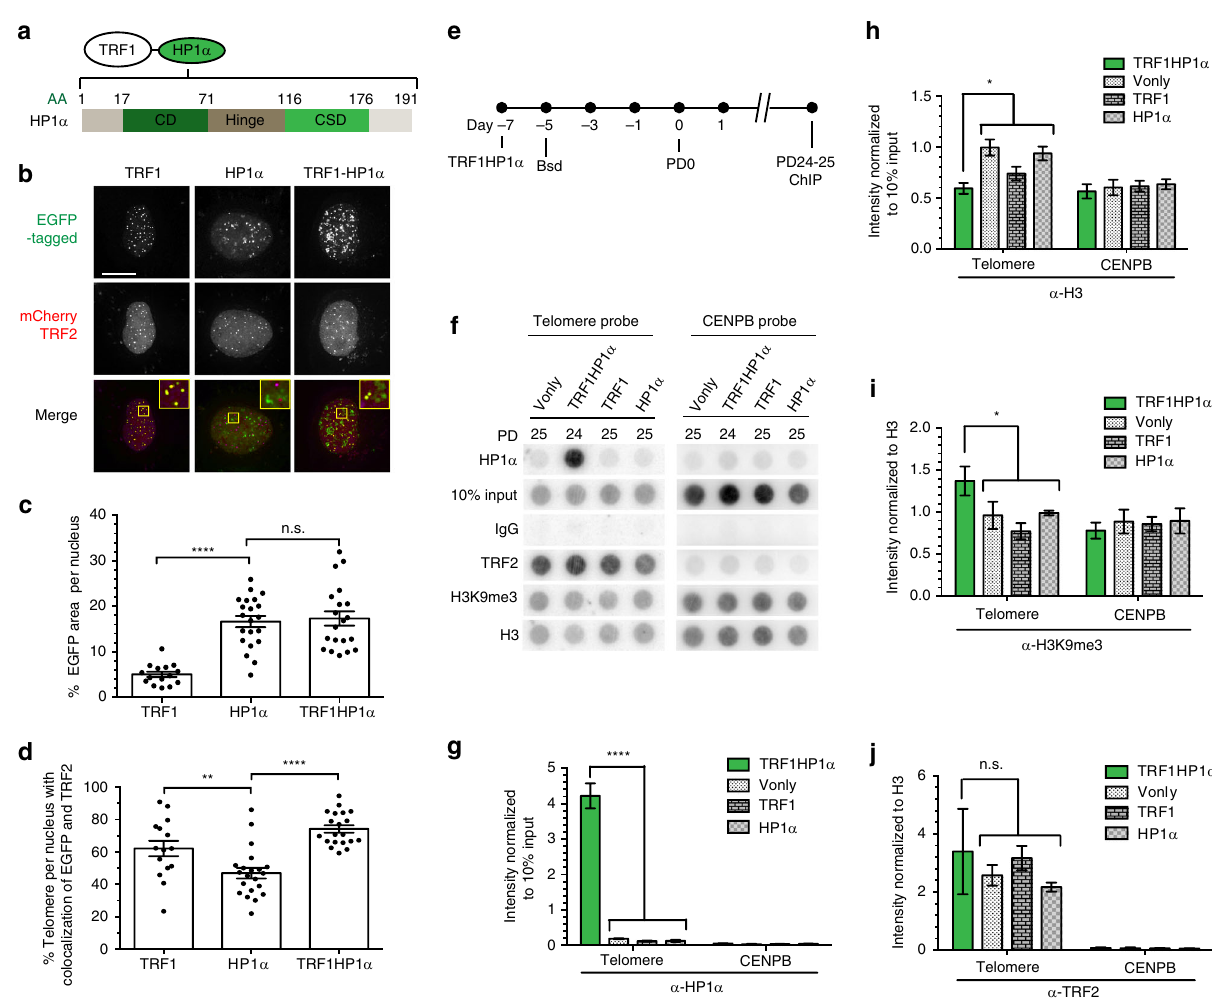
Fig. 1 Tethered HP1 α at telomeres locally increases H3K9me3. a Schematic of HP1 α fused to TRF1. HP1 α consists of a chromo domain (CD), a hinge, and a chromo shadow domain (CSD); AA (amino acid). b − d Fluorescence imaging of UM-UC3 cells cotransfected with mCherry-tagged TRF2 and EGFP-TRF1, EGFP-HP1 α , or EGFP-TRF1HP1 α -fusion 48 h after transfection ( n = 15 – 21 nuclei). b Representative images. mCherry shown as magenta in merged image. Scale bar: 10 µ m. c Quanti fi cation of % EGFP area per nucleus **** p < 0.0001; n.s. (no signi fi cance). d Quanti fi cation of % telomere per nucleus with colocalization of EGFP and TRF2 (mCherry) ** p = 0.0065; **** p < 0.0001. The high apparent colocalization of HP1 α with TRF2 (within the HP1 α group)